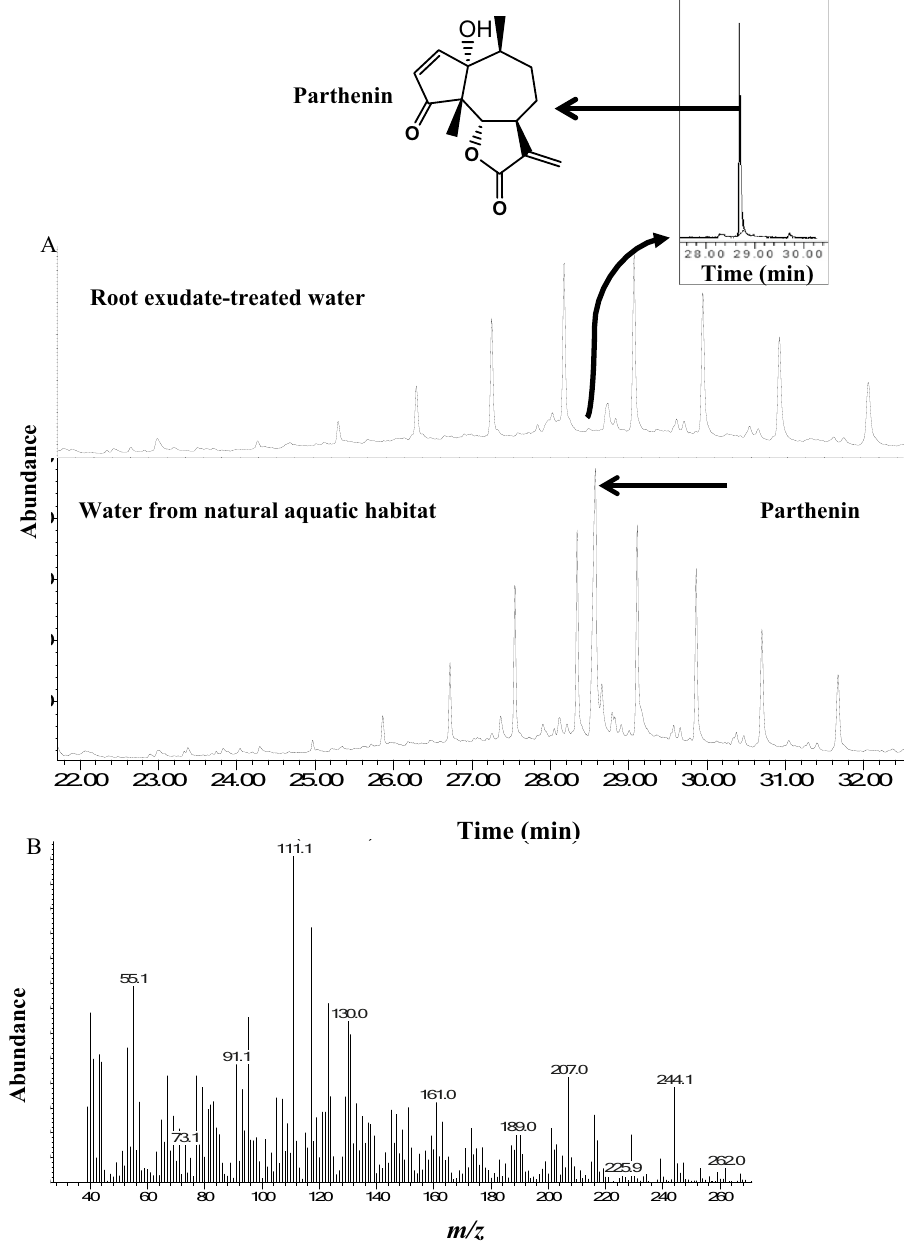
Figure 2. Chemical analysis of root exudate. ( A ) Total ion chromatogram (TIC) showing root exudate profile as detected by GC/MS: Shown in insert is the Extracted ion chromatogram (EIC) of parthenin from the root exudate water sample. ( B ) Mass spectrum of